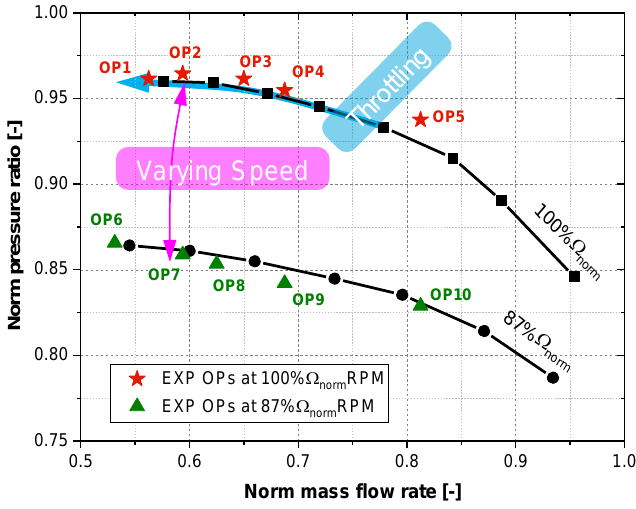
Figure 3. Operation line and experimental measurement scheme of the compressor facility.